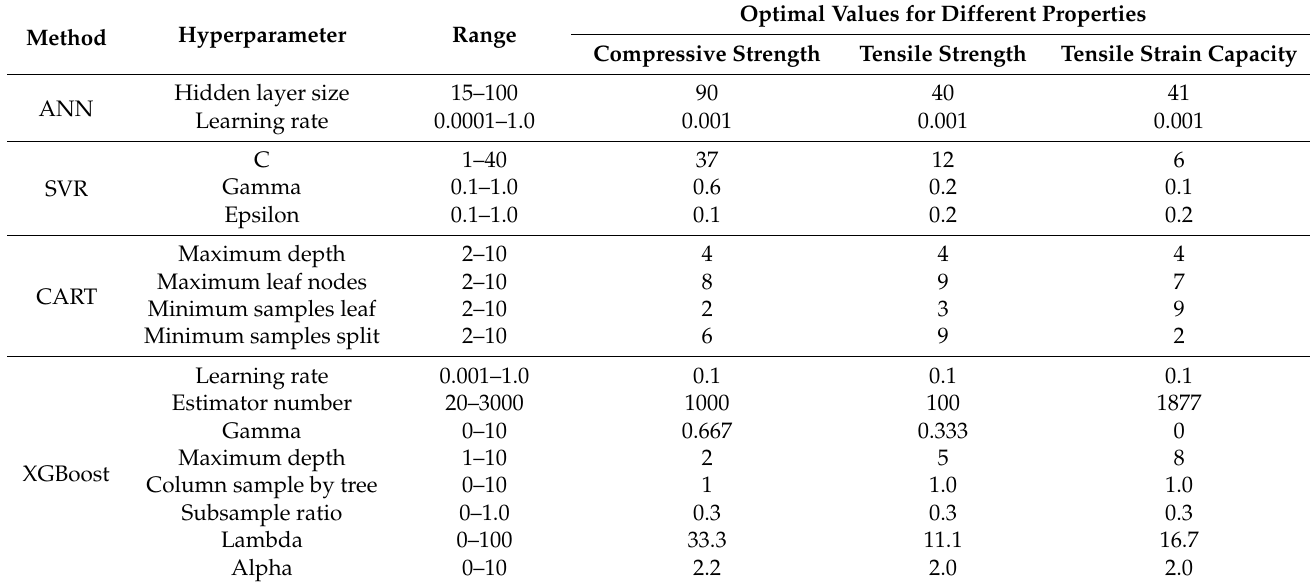
Table 3. The optimal hyperparameters for the machine learning methods.